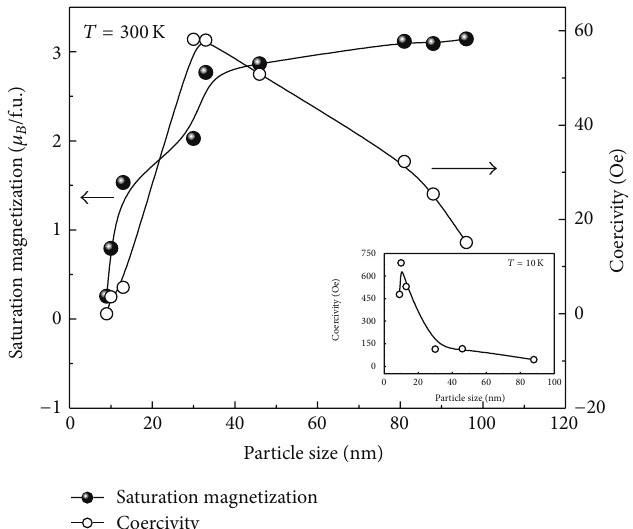
Figure 7: Saturation magnetization and coercivity at 300K versus particle size of the nanosized Ni-Zn ferrites. The inset shows particle size dependence of the coercivity at